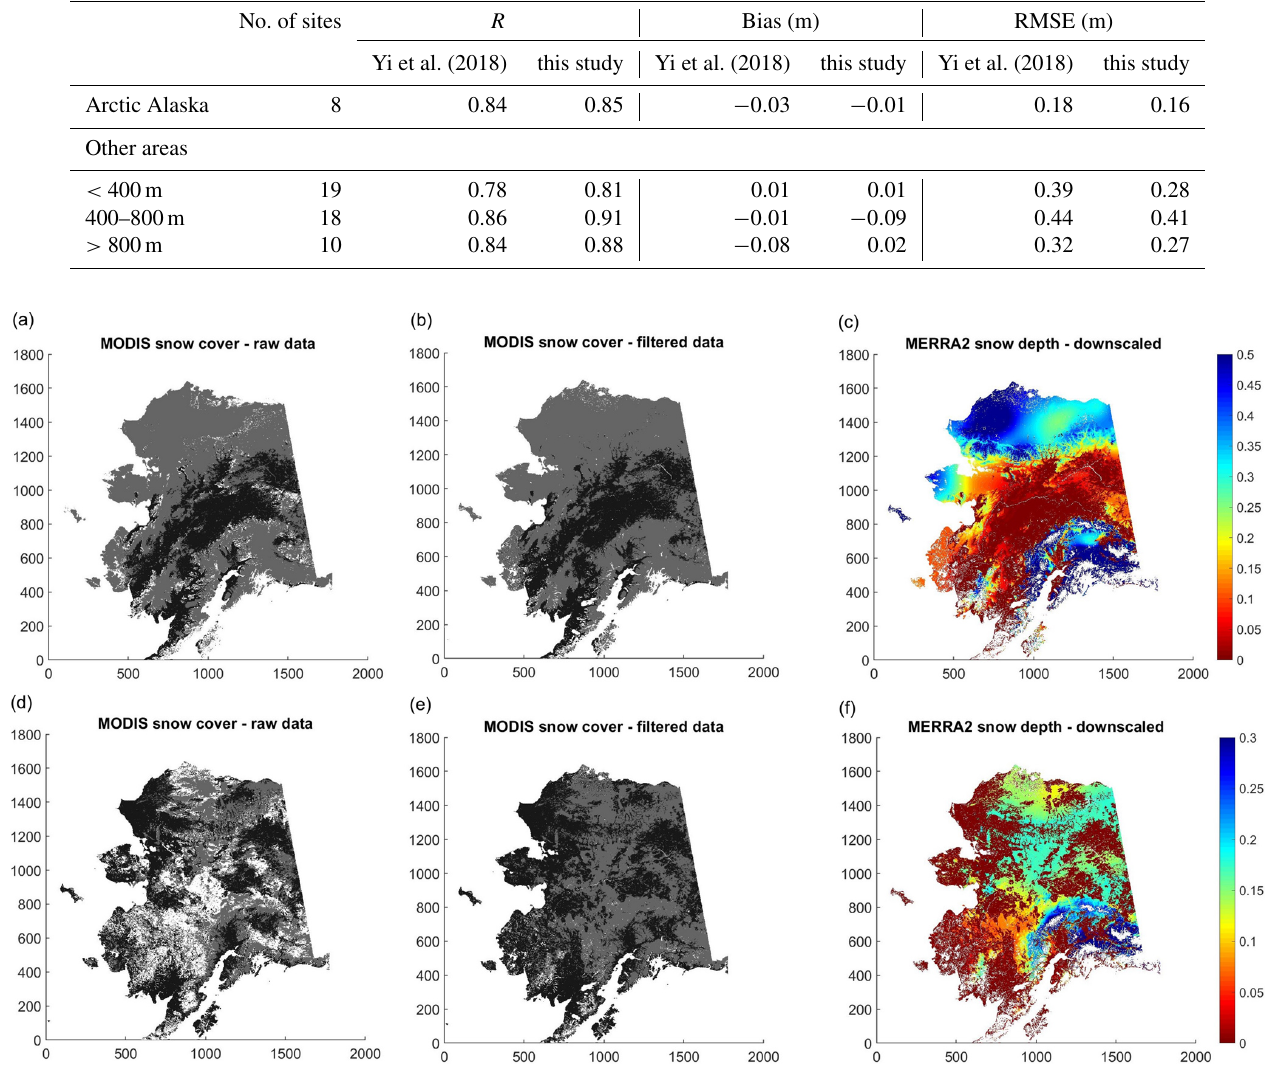
Figure 5. Illustration of the snow data processing: the raw (a, d) and cloud-filtered (b, e) MODIS SCE images using an elevation-based spatial filter and downscaled MERRA-2 snow depth (in meters) data (c, f) using the filtered MODIS SCE and DEM data during spring snow melt ( a–c : 23–30 April) and early snow accumulation ( d–f : 30 September–7 October) period in 2007. In the MODIS images, snow-covered areas are shown in gray, while land and cloud-covered areas are shown in black and white,